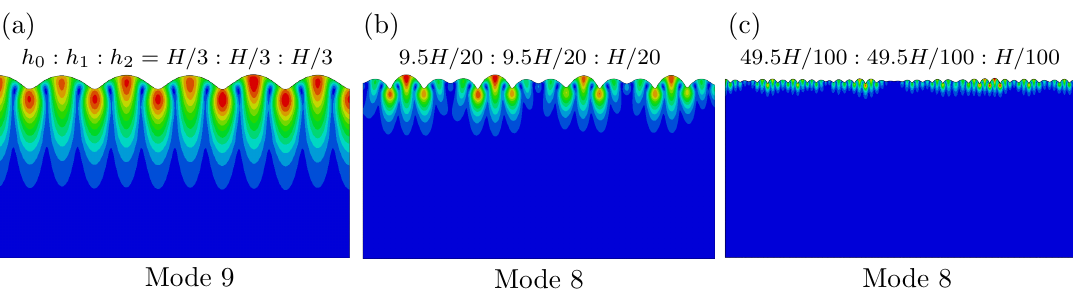
Figure 8. Buckling modes for three-layer models with different heights of each layers. ( a ) case I h 0 : h 1 : h 2 = H /3: H /3: H /3; ( b ) case II h 0 : h 1 : h 2 = 9.5 H /20:9.5 H /20: H /20; ( c ) case III h 0 : h 1 : h 2 = 49.5 H /100:49.5 H /100: H